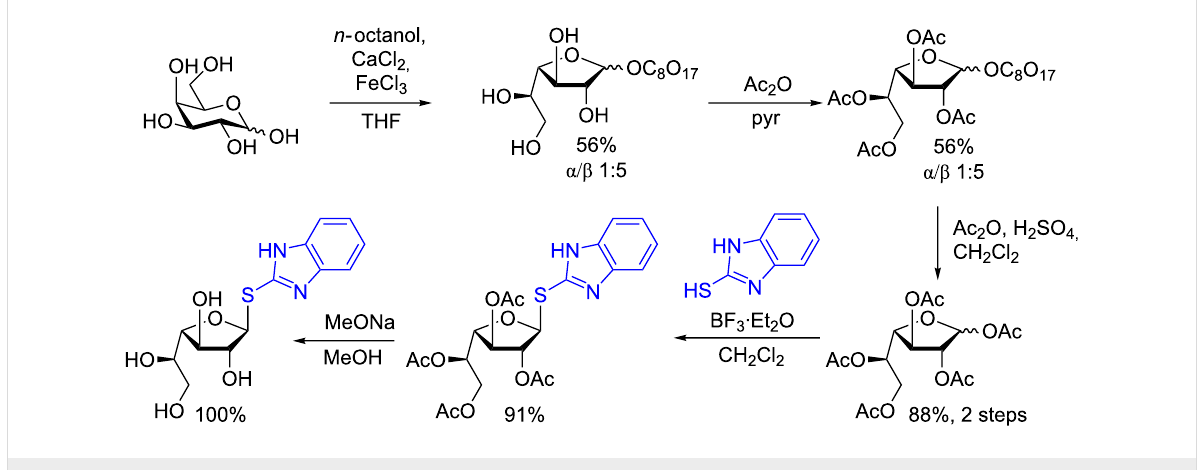
Scheme 12: Synthesis of the 1-thioimidoyl galactofuranosyl donor.